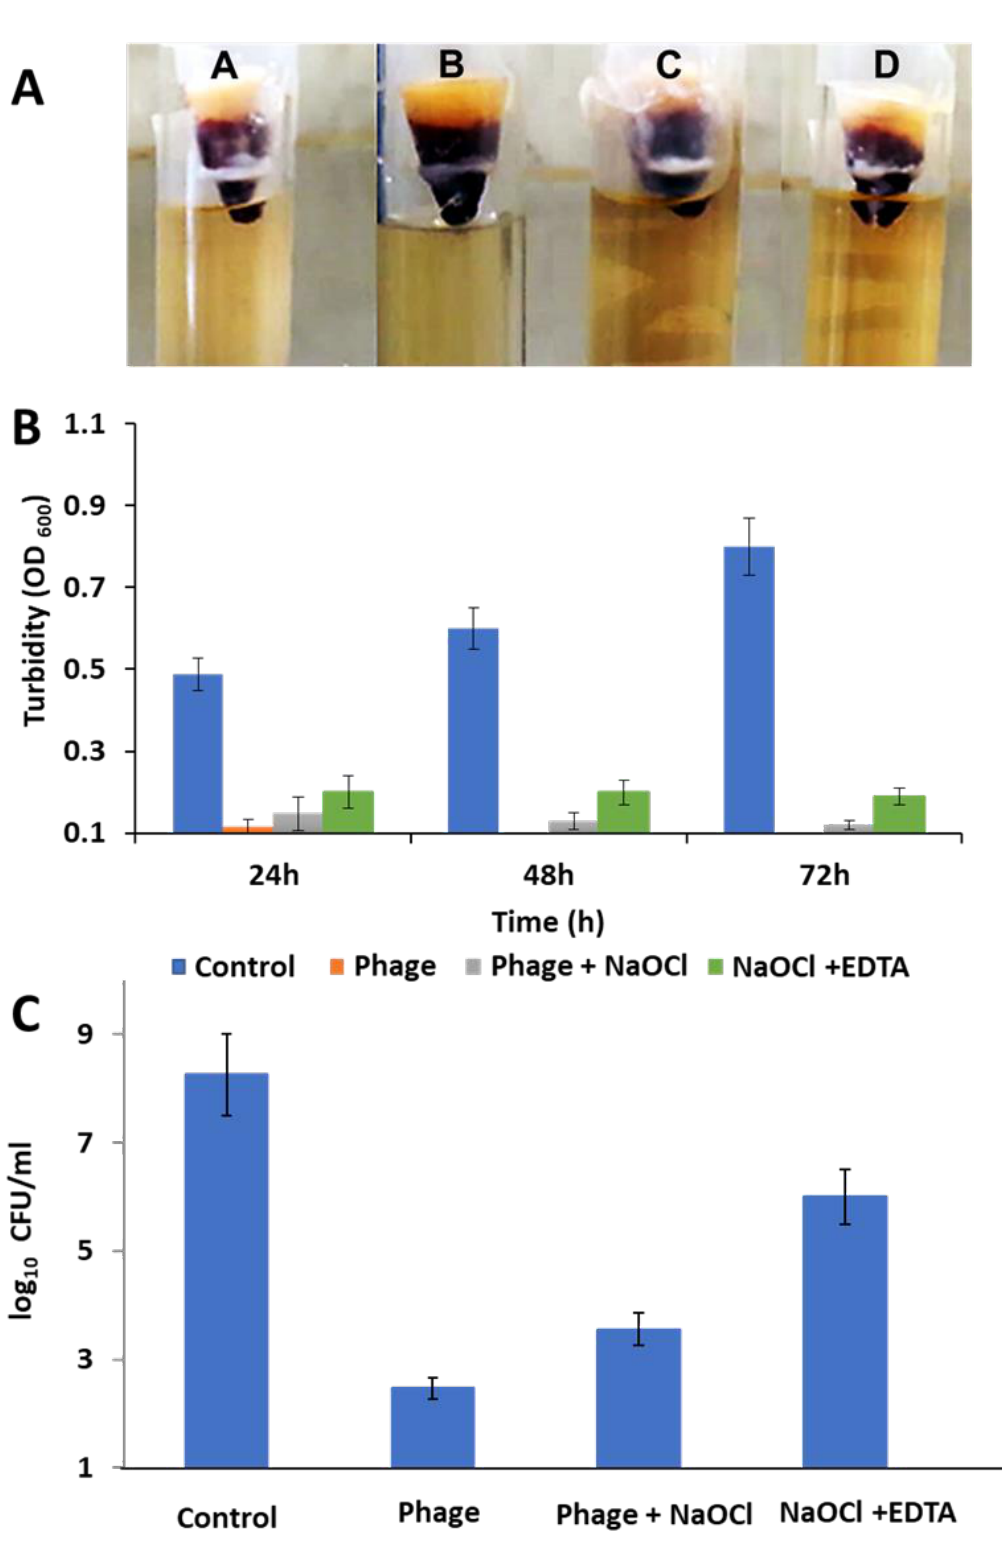
Figure 7. Irrigation efficiency of E. faecalis infected root canals. Panel ( A ) shows the two-chamber leakage model from root canals infected with E. faecalis isolate 4 and irrigated with either A. saline solution (control); B. phage treatment (vB_ZEFP 10 8 PFU/mL); C, phage plus 2.5% NaOCl; D. 2.5% NaOCl and 17% EDTA. Panel ( B ) shows culture turbidity measured every 24 h at OD600. Panel ( C ) shows viable counts after 72 h. Error bars indicate ± standard deviation of the mean.